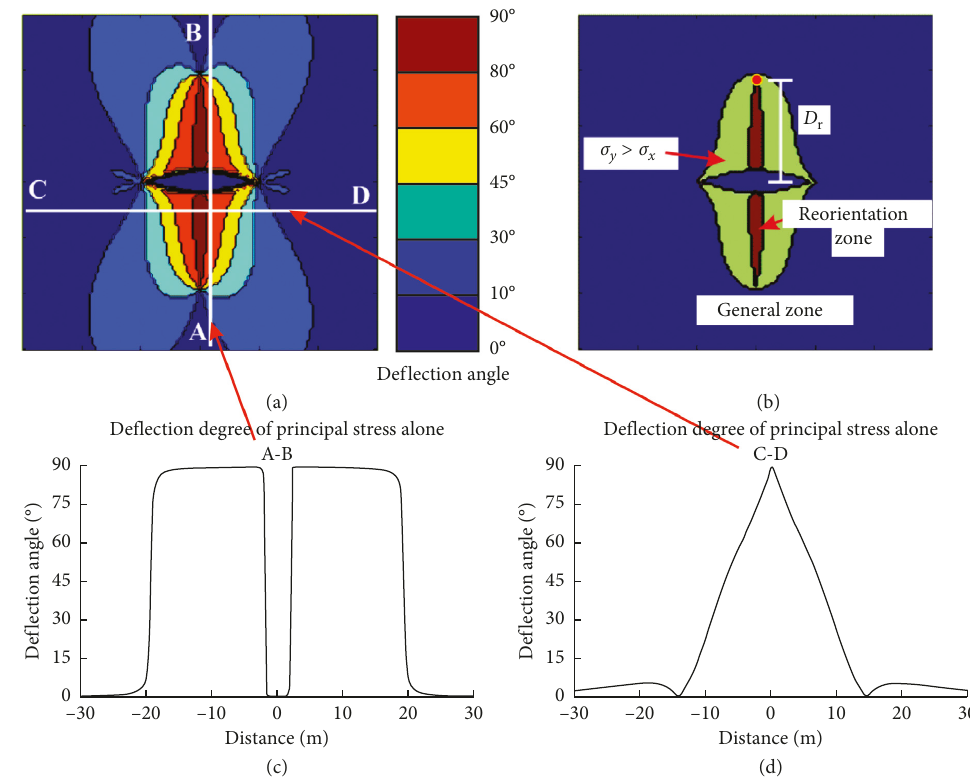
Figure 7: Spatial distribution of the in situ stress deflection